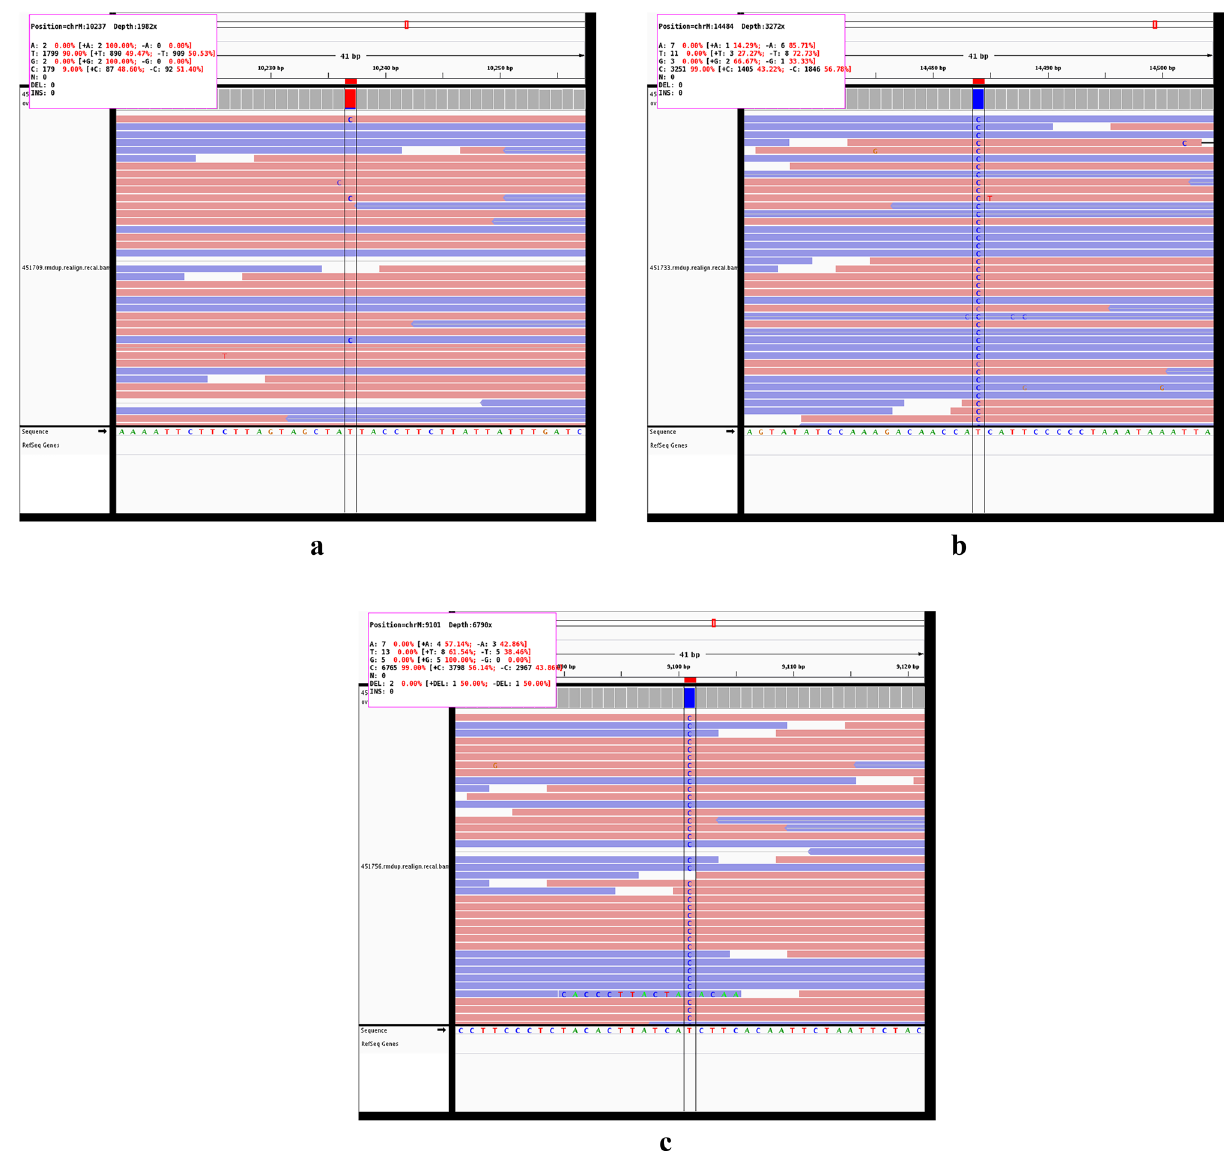
Figure 1. HiSeq X NGS short reads of rare and primary LHON mutations found in two RRMS patients. ( a ) m.10237T>C (p.Ile60Thr) rare mutation of MT-ND3 gene. ( b ) m.14484T>C (p.Met64Val) primary mutation of MT-ND6 gene. ( c ) m.9101T>C (p.Ile192Thr) rare mutation of MT-ATP6